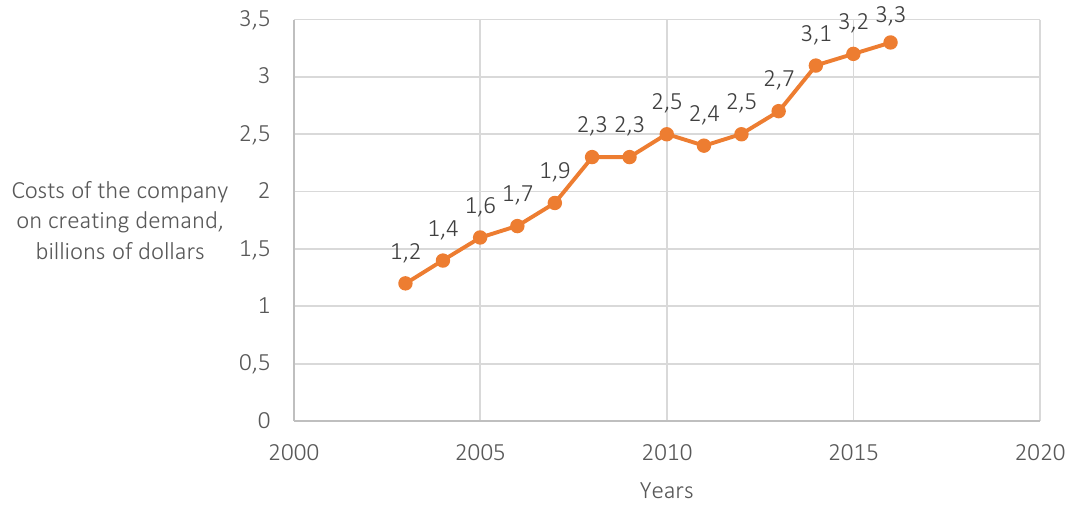
Figure 6. Costs on creating demand by the company Nike, in billions of